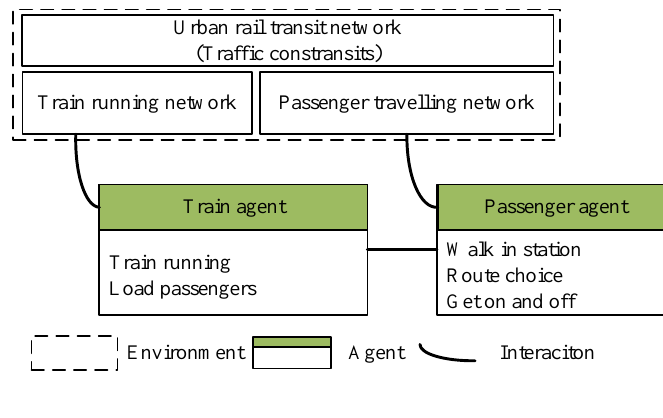
Figure 1. Interactions of main